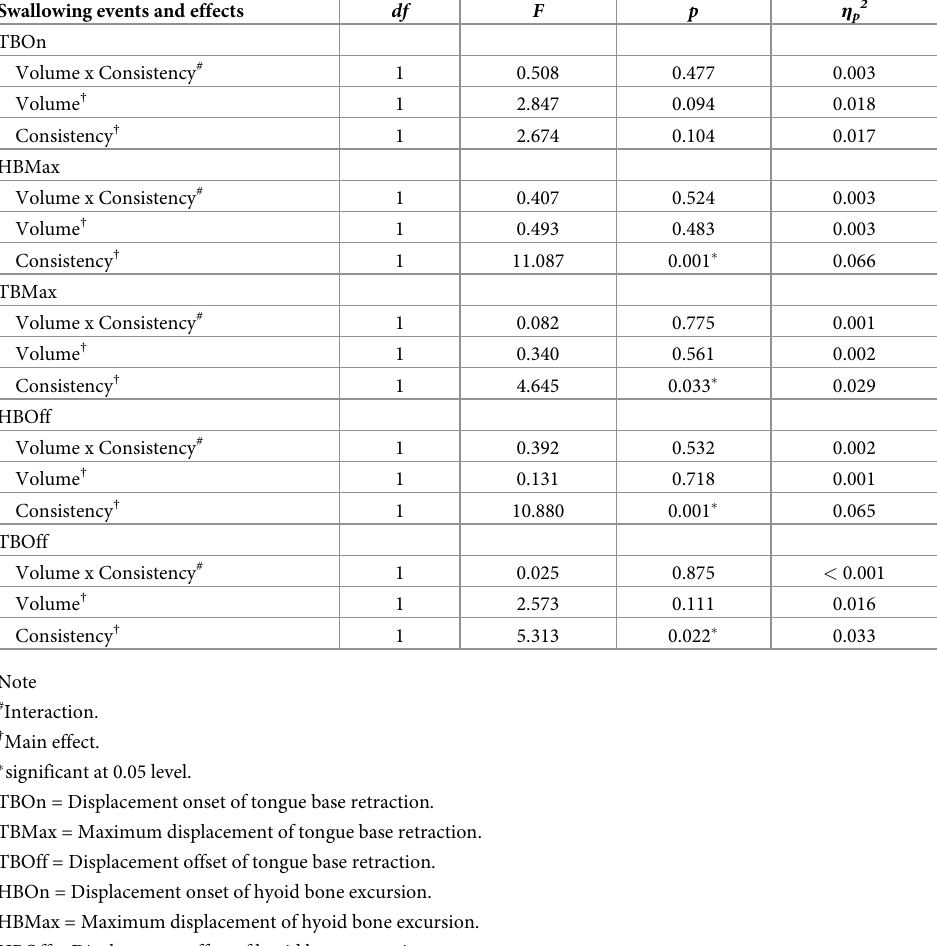
Table 3. Results of the two-way ANOVAs on the time difference between the onset of hyoid bone excursion ( HBOn ) and different events. Swallowing events and